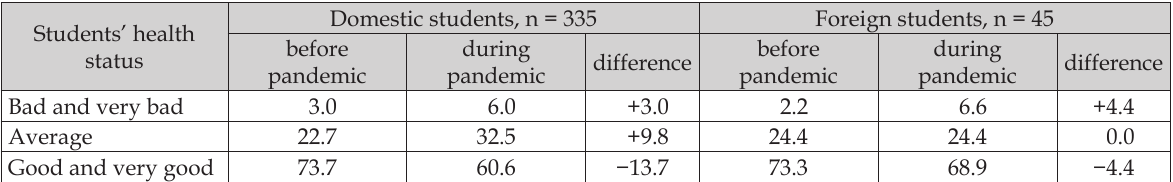
Table 4. Self-assessment of health by domestic and foreign students in Lublin, Kyiv and Minsk before and dur - ing the pandemic, % (n =